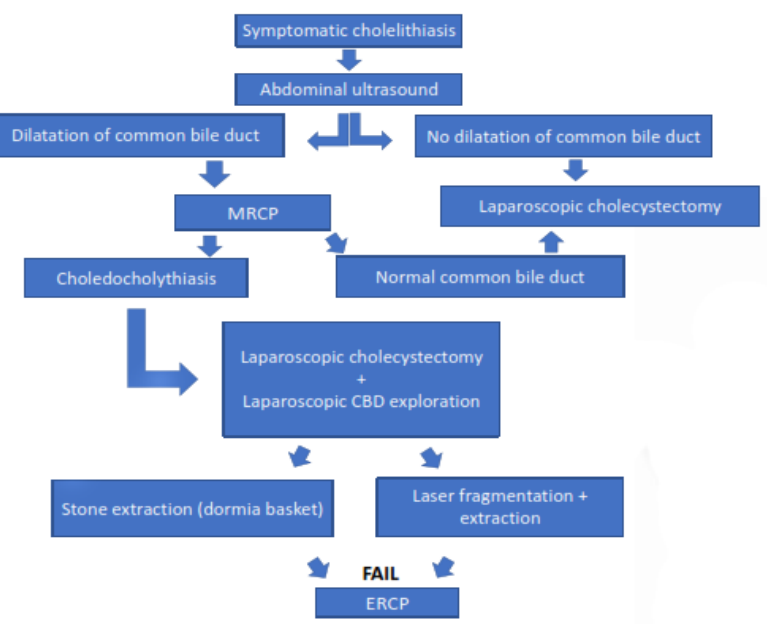
Figure 3. Algorithm of treatment of the pediatric patients with